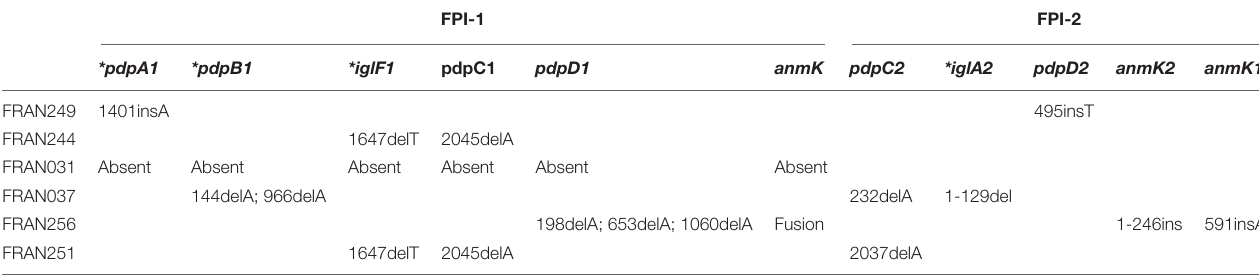
TABLE 3 | Mutations identified in the Francisella pathogenicity islands.